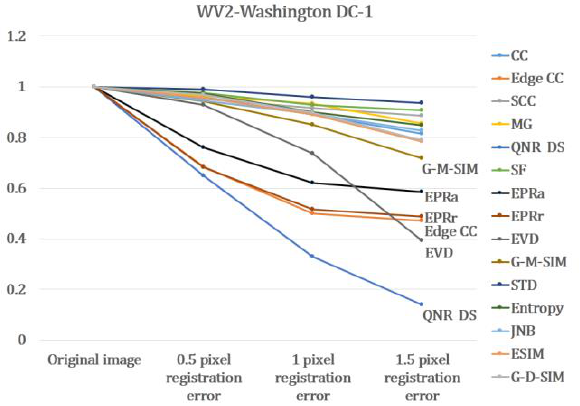
Figure 12. Comparative charts of metrics on data